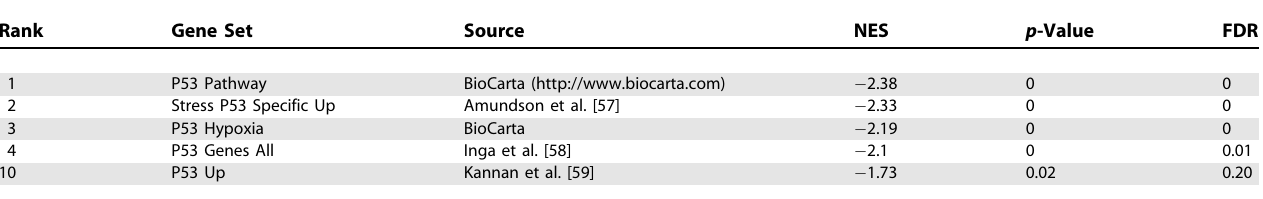
Table 1. GSEA Results for the P53 Gene Sets in the Wild-Type/P53 Mutant Dataset Rank Gene Set